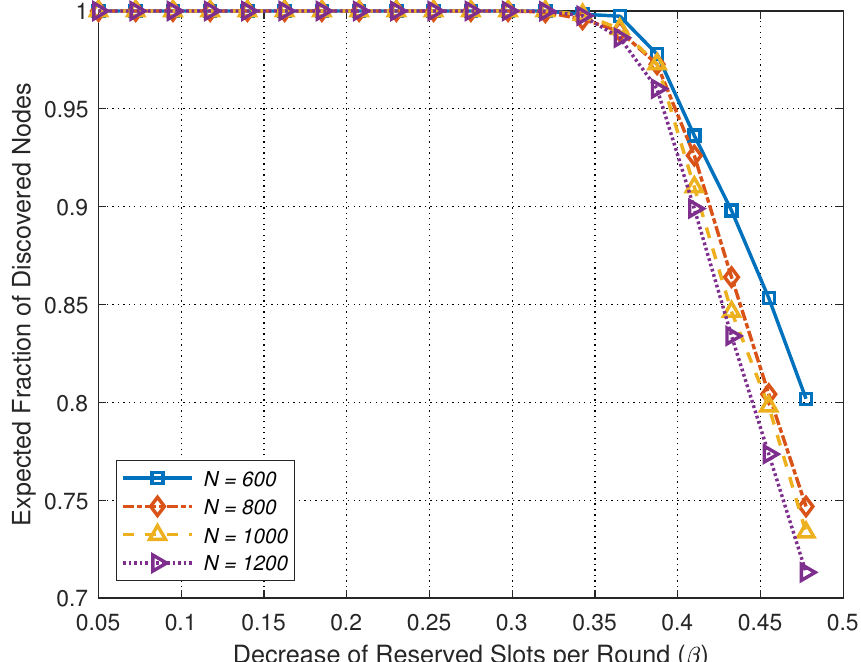
Figure 15. Time for discovery vs. β .